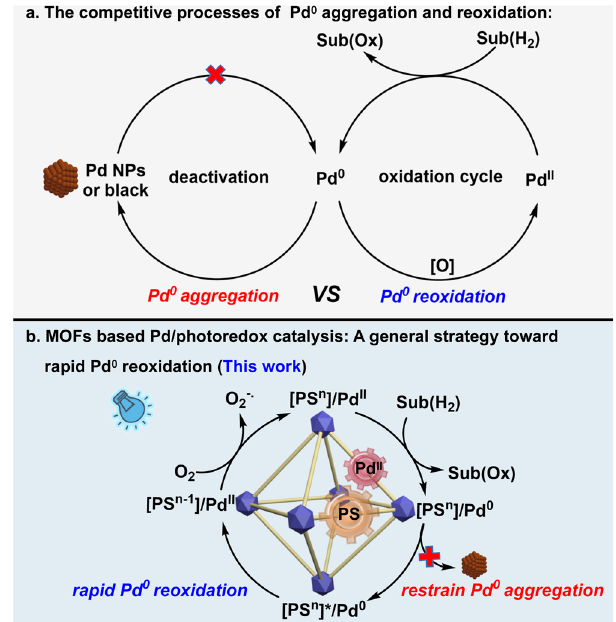
Fig. 1 Schematic illustration of Pd reoxidation. a The competitive processes of Pd 0 aggregation and reoxidation in Pd-catalyzed oxidation reactions, the existing strategies toward Pd 0 reoxidation suffer from low Pd turnover number, high-pressure O 2 atmosphere, organic waste, low atom economy, separation dif fi culty. b MOFs based Pd/photoredox catalysis for Pd 0 reoxidation with high Pd turnover ef fi ciency, atom economy, environmental-friendliness, and